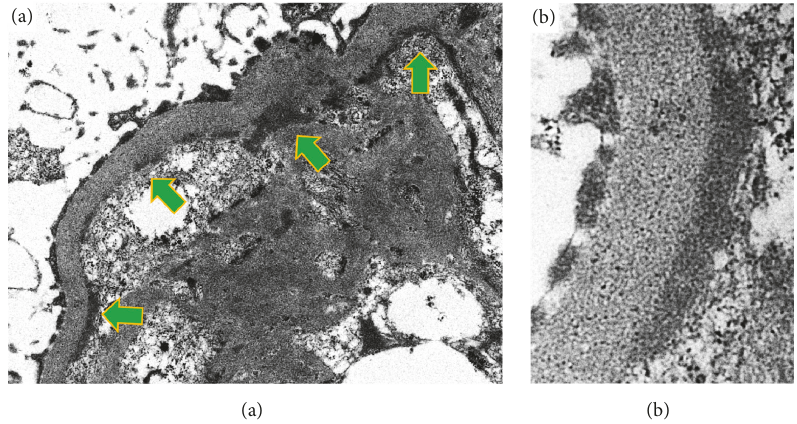
Figure 3: Electron microscopy findings. Electron microscopic examination showed nonorganized deposits in the subendothelial area along the glomerular basement membrane and paramesangial area ((a), original magnification 12,000 × ; (b), original magnification 50,000 × ). Becausenoglomeruliwereidentifiedintheportionofthebiopsyspecimenfixedinglutaraldehyde,theformalin-fixedandparaffin-embedded specimen was reprocessed for electron microscopy. Arrows indicate nonorganized